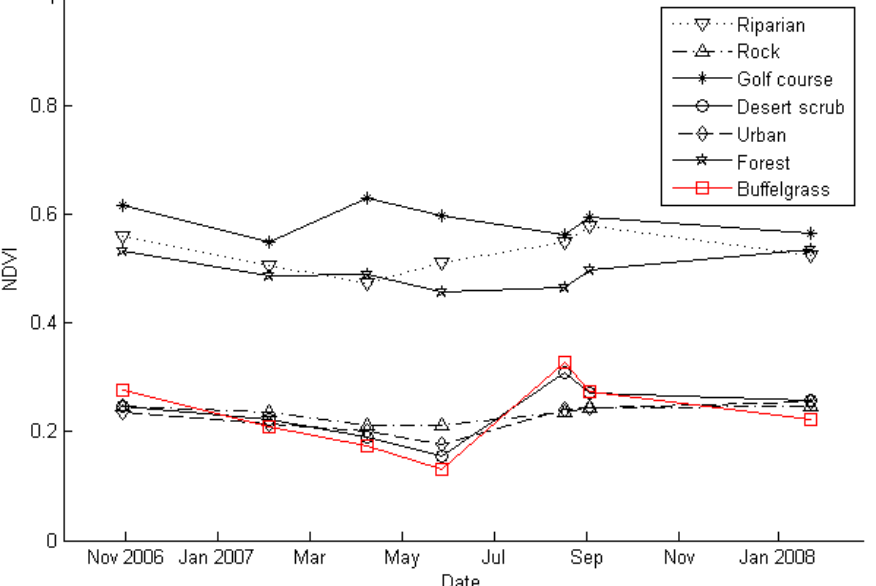
Figure 8. Mean Normalized difference vegetation index (NDVI) values of training points based on Landsat-5 TM scenes from seven dates over 15 months between 2006 and